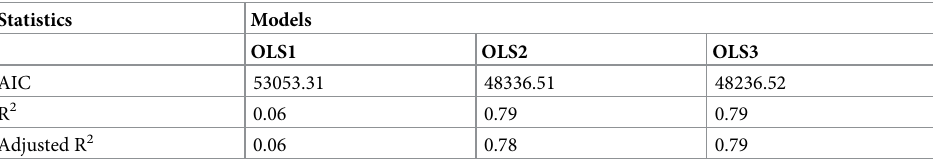
Table 3. Summary of OLS